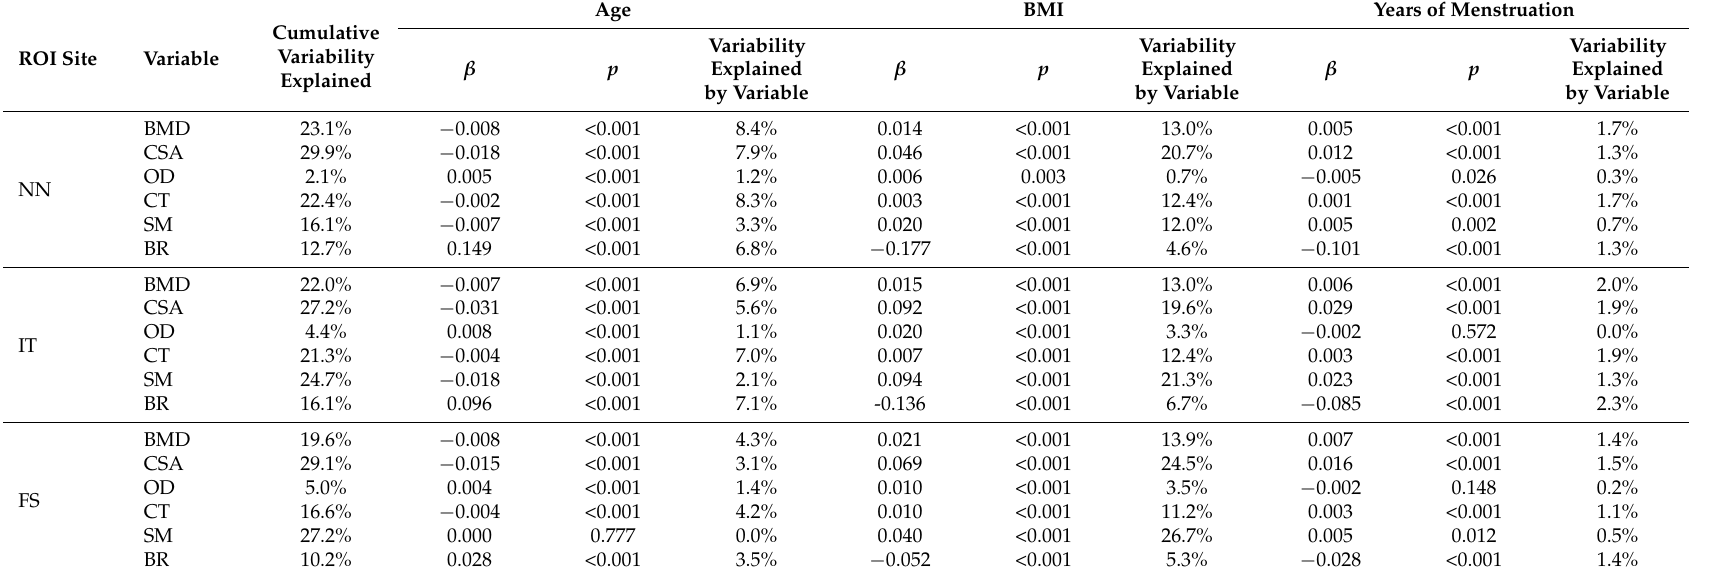
Table 2. Association results of age, BMI and years of menstruation with BMD and HSA